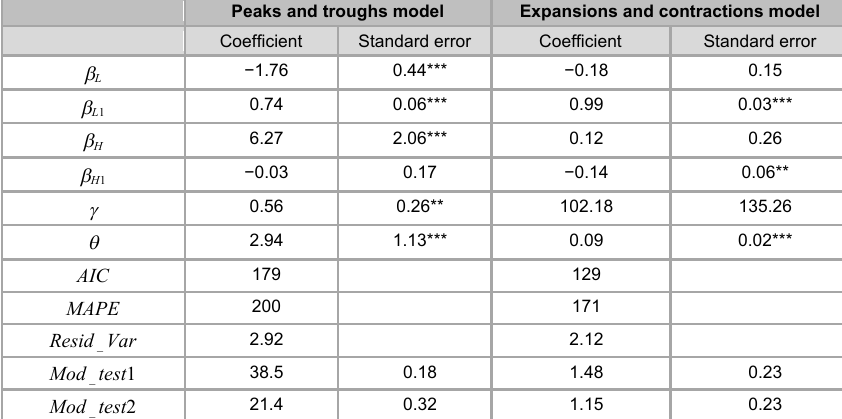
Logistic smooth transition autoregressive models results Peaks and troughs model Expansions and contractions